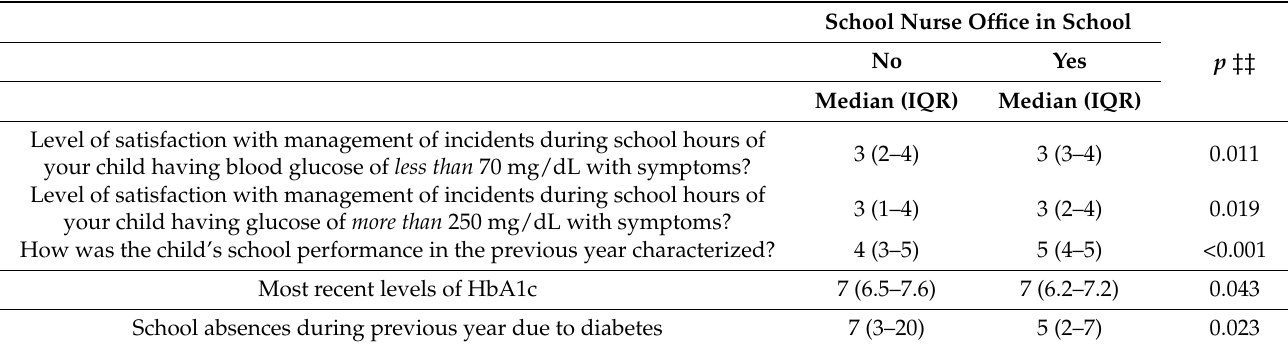
Table 3. Participants’ satisfaction with the management of low or high glucose incidents during school hours, the child’s school performance in the previous year, the most recent levels of HbA1c and correlation of children’s absences due to diabetes with the existence of a school nurse’s office.